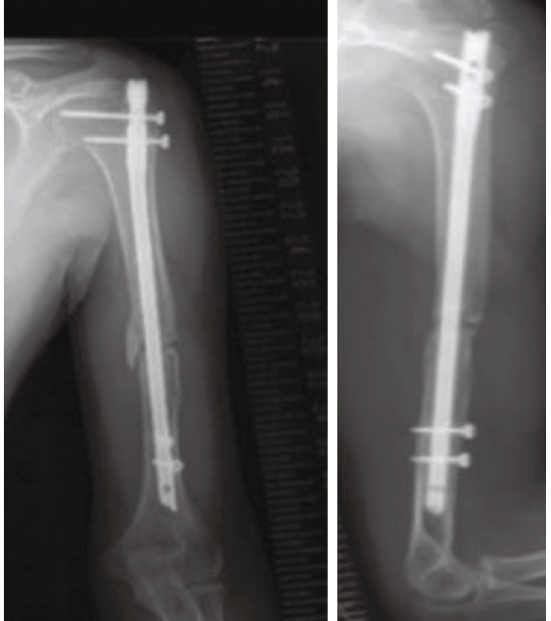
Figure 3: Radiographs at the fi rst visit to our hospital. Nonunion was observed with callus formation on the medial side.